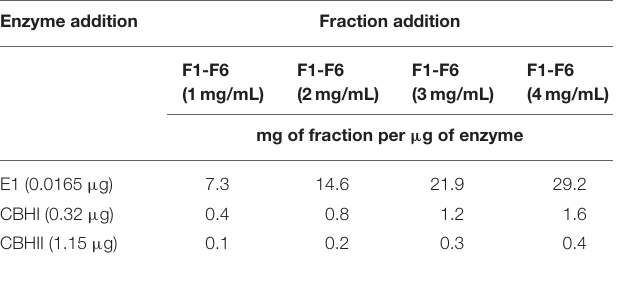
TABLE 1 | Composition of MUC assay with a total volume of 120 µ L. Enzyme addition